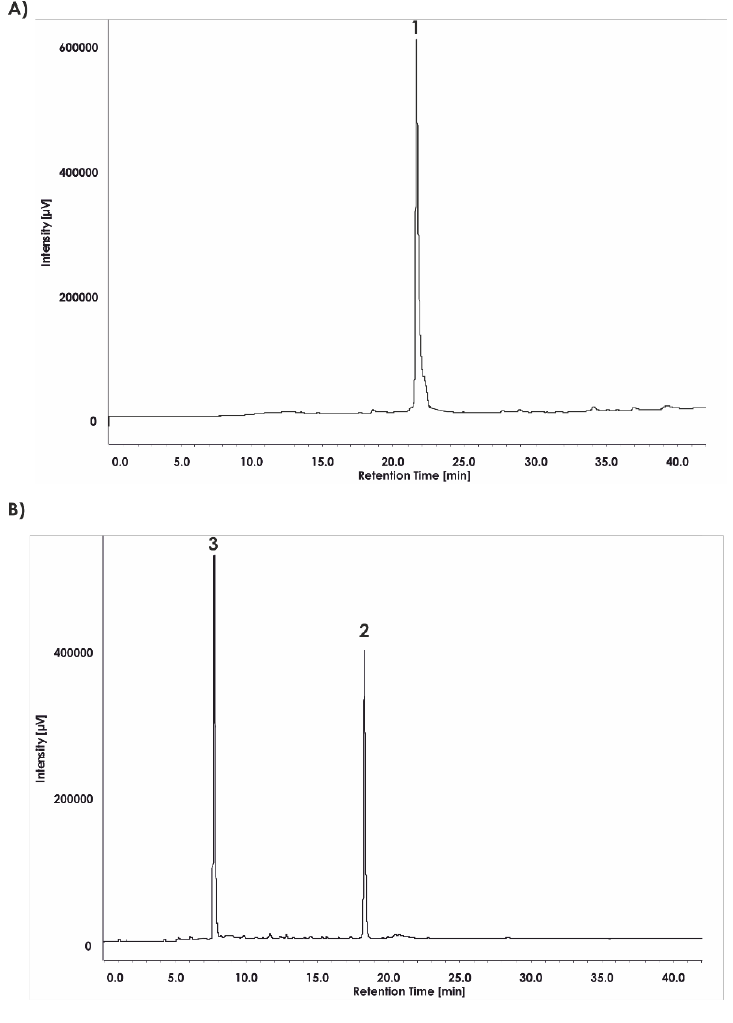
Figure 3. Reverse phase-high-performance liquid chromatography (RP-HPLC) analysis of ( A ) compound 1 (t R = 22.41) and ( B ) compound 1 incubated with the 20S proteasome for one hour. The fragment ABZ–Dap(O2(Cbz))–Dap(GO1)–Dap(O2(Cbz))–Arg–OH ( 2 ) has a retention time of t R = 18.2 and ANB–NH 2 ( 3 ), t R = 7.89.